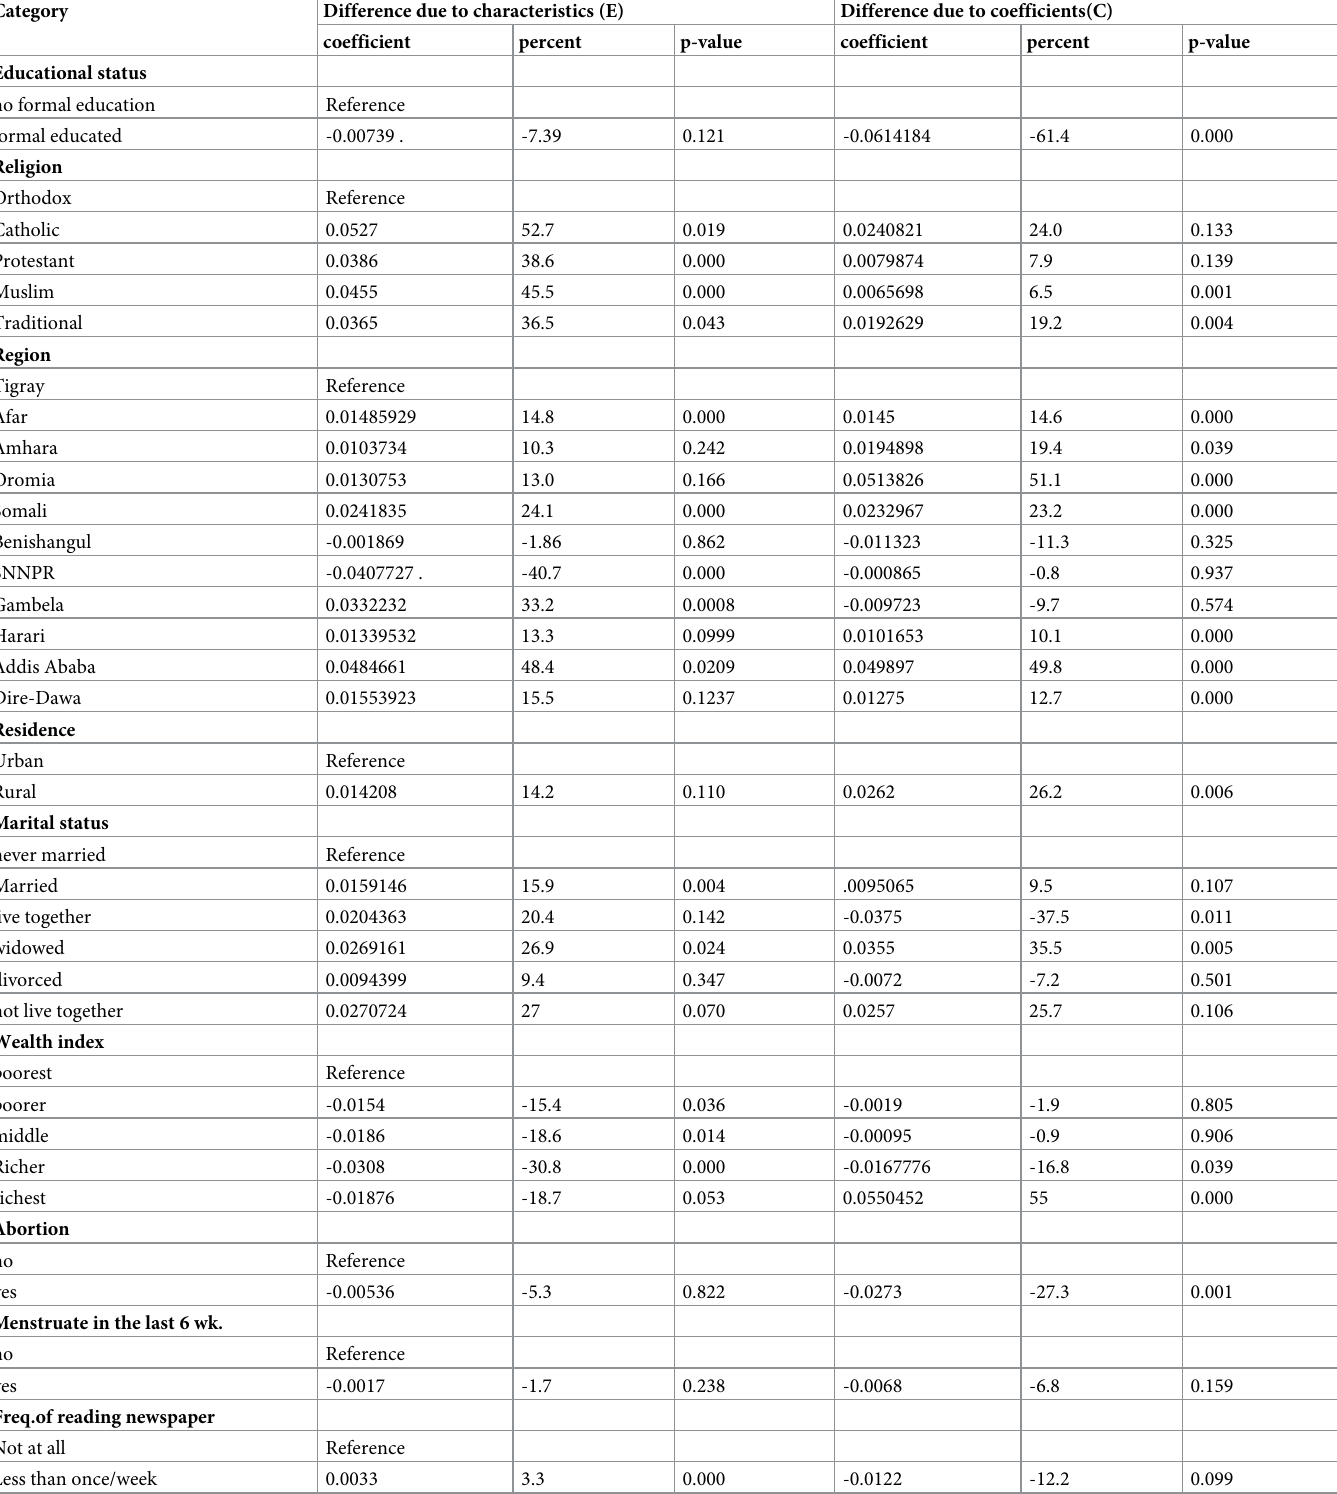
Table 4. Decomposition change of anemia among women in reproductive age (N =